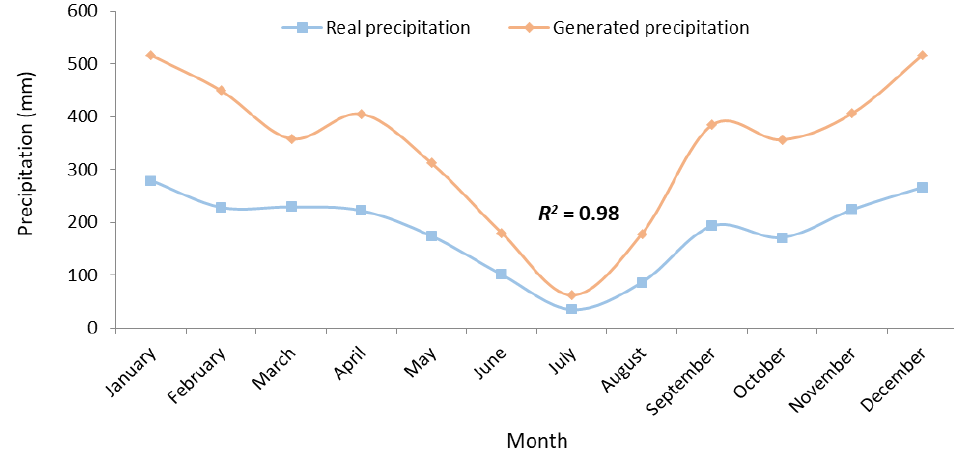
Figure 3. Real (1992 – 2019) vs. generated (2020 – 2070) mean temperature.